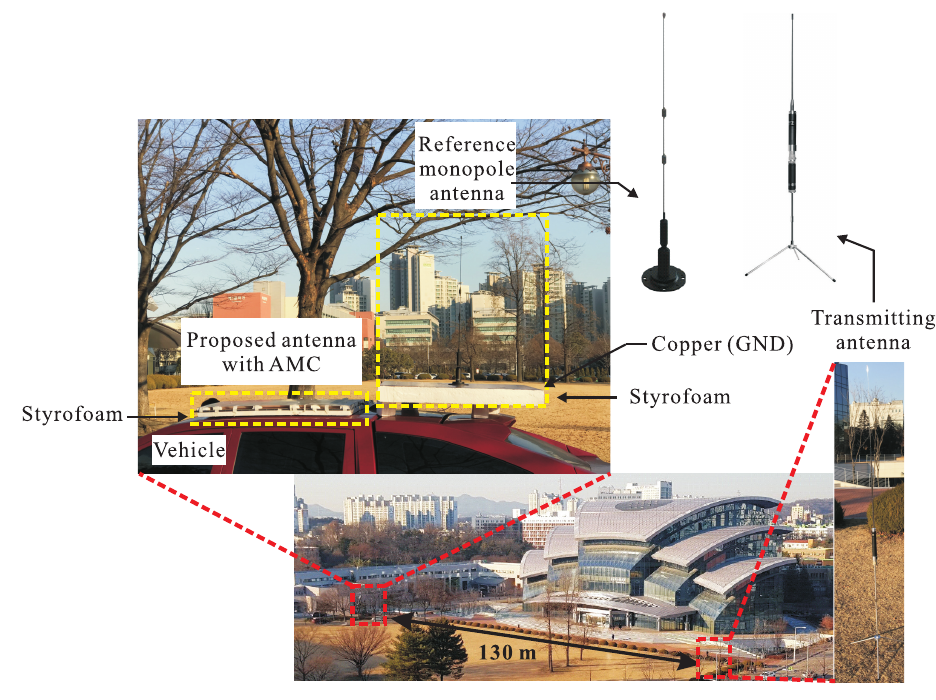
Figure 11. Receiving power measurement setup.